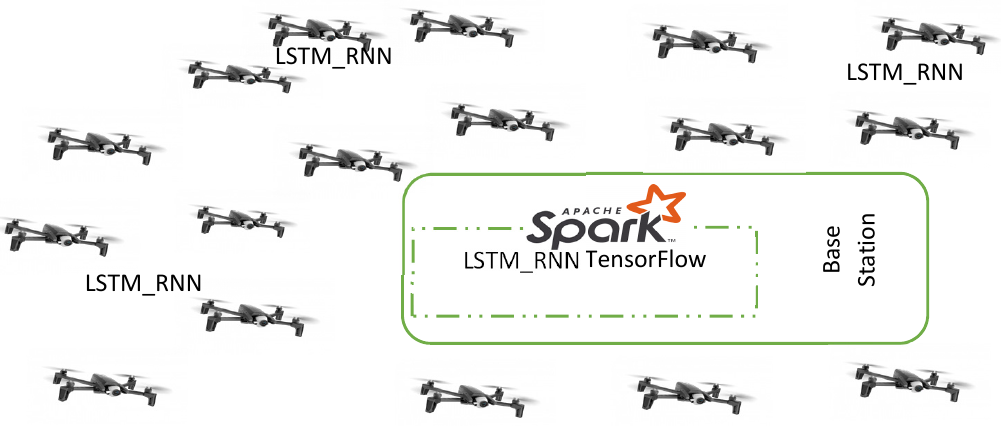
Figure 10. Base station Spark LSTM_RNN.